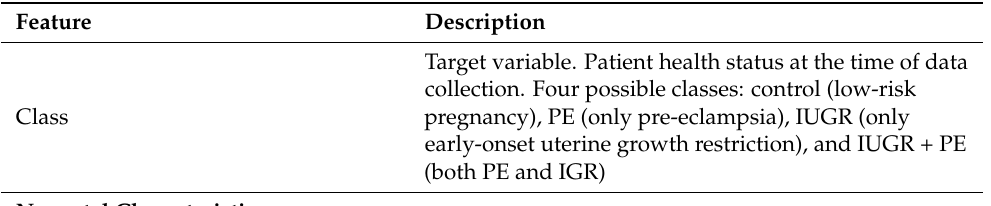
Table 1. Features available in the dataset